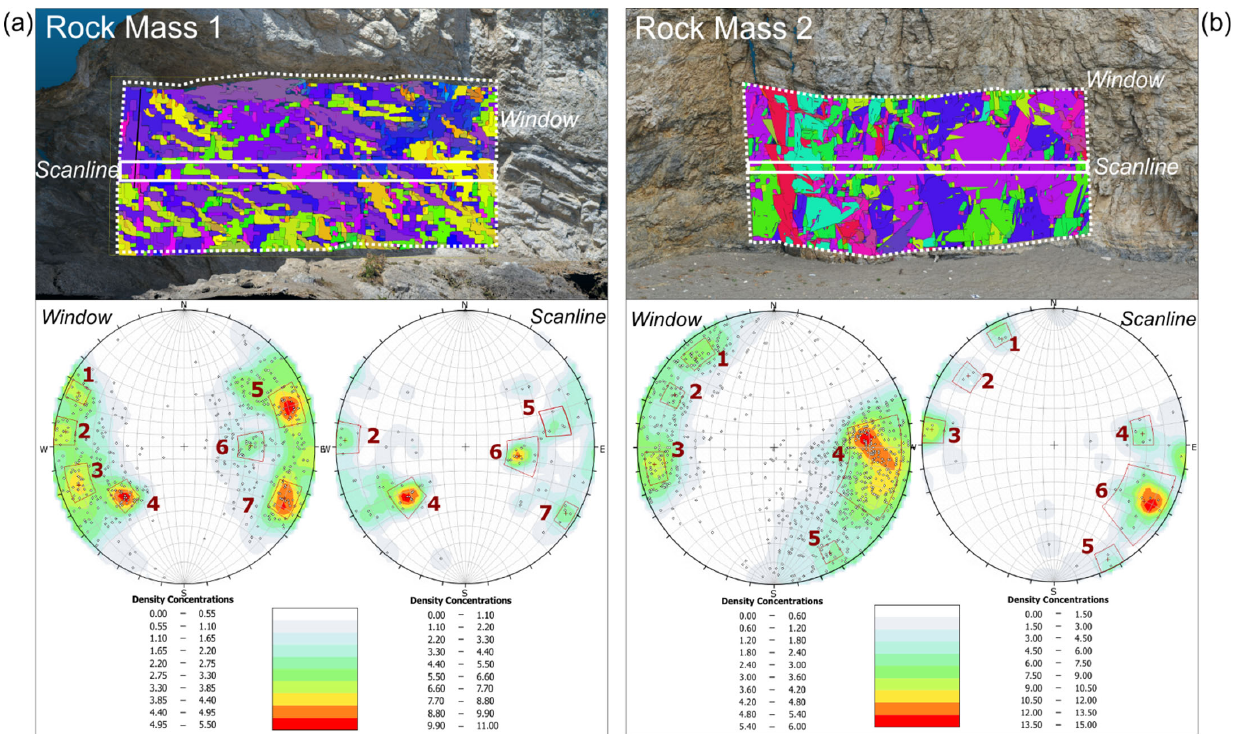
Figure 3. Outcomes of the discontinuity extraction by K ‐ D tree algorithm according to both a surveying window and a scanline at RM1 ( a ) and RM2 ( b ). Table 1. List of the discontinuity sets extracted by K ‐ D tree algorithm through both survey window and scanline; n.a. is reported when the corresponding discontinuity set was not detected.